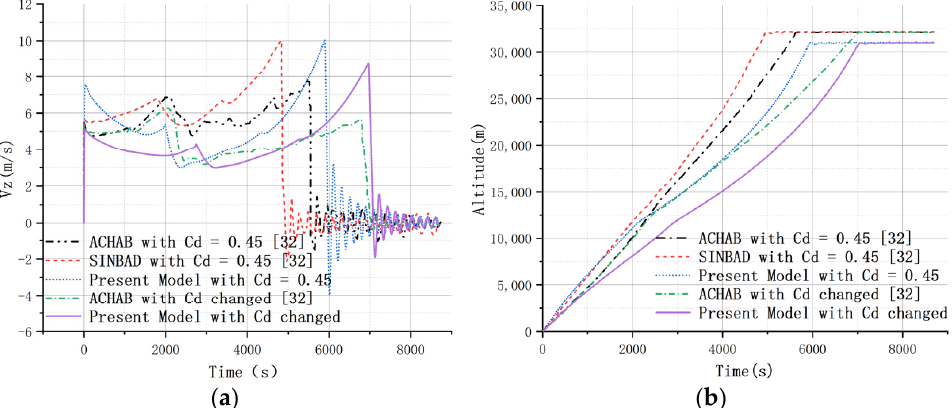
Figure 6. Simulation results. ( a ) shows the comparison of vertical speed vs. time. ( b ) shows the comparison of altitude vs. time.